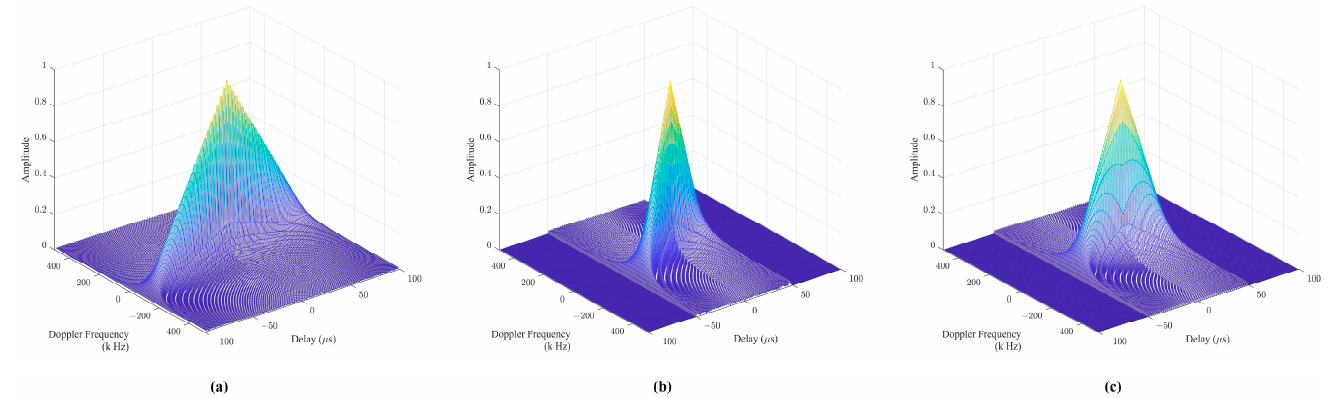
Figure 1. Ambiguity function of radar emitters. ( a – c ) are the AF of three radar emitters and different colors represent different height information.